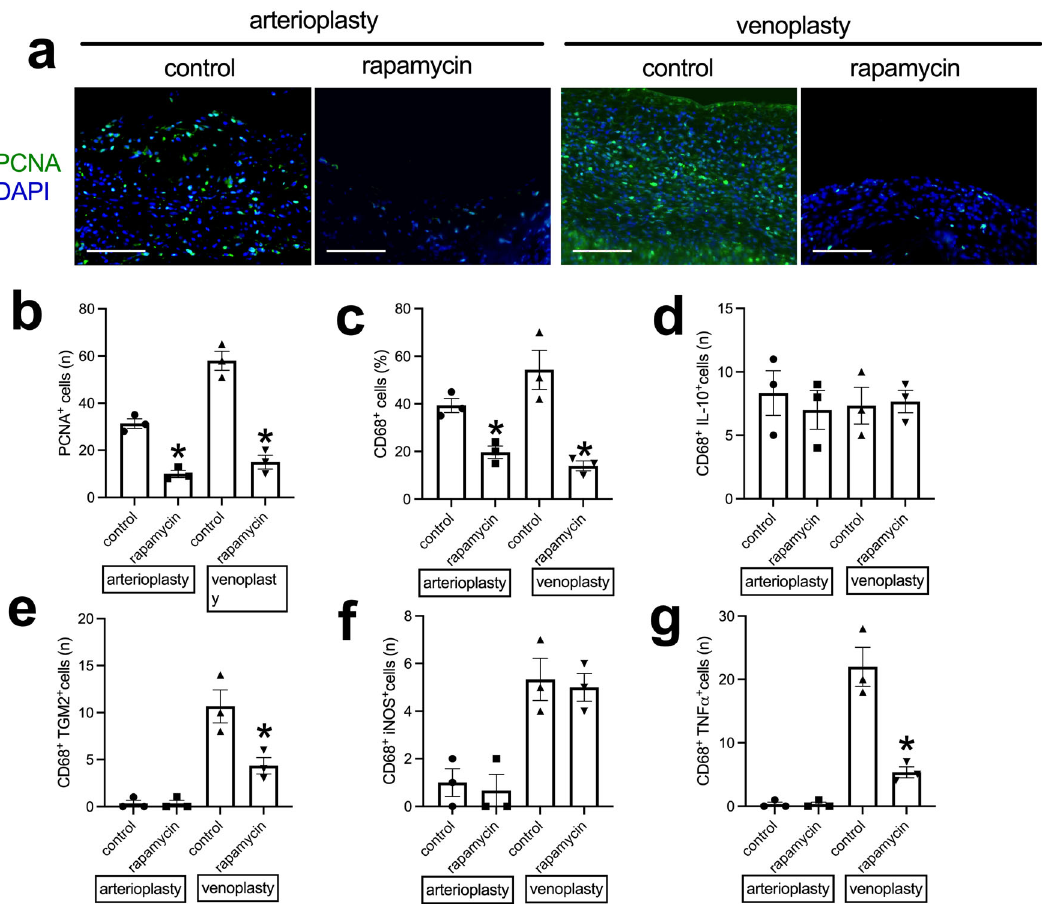
Fig. 5 Neointimal cell proliferation and macrophage identity in the control or rapamycin-coated patches harvested from aorta arterioplasty or IVC venoplasty, day 14. a Photograph of the immuno fl uorescence merged of PCNA (green) and DAPI (blue) of the patches; scale bar, 100 μ m; n = 3. b Bar graph showing the neointimal PCNA-positive cells in the control or rapamycin-coated patches in the arterioplasty (* p = 0.0011) or venoplasty (* p = 0.0010) models, day 14; t -test; n = 3. c Bar graph showing the neointimal CD68-positive cells in the control or rapamycin-coated patches of the arterioplasty (* p = 0.0076) or venoplasty (* p = 0.0090) models, day 14; t -test; n = 3. d Bar graph showing the CD68 and IL-10 dual-positive cells in the control or rapamycin-coated patches in the arterioplasty ( p = 0.5983) or venoplasty ( p = 0.8541) models, day 14; t -test; n = 3. e Bar graph showing the CD68 and TGM2 dual-positive cells in the control or rapamycin-coated patches in the arterioplasty ( p > 0.9999) or venoplasty (* p = 0.0325) models, day 14; t -test; n = 3. f Bar graph showing the CD68 and iNOS dual-positive cells in the control or rapamycin-coated patches in the arterioplasty ( p = 0.7247) or venoplasty ( p = 0.7676) models, day 14; t -test; n = 3. g Bar graph showing the CD68 and TNF- α dual-positive cells in the control